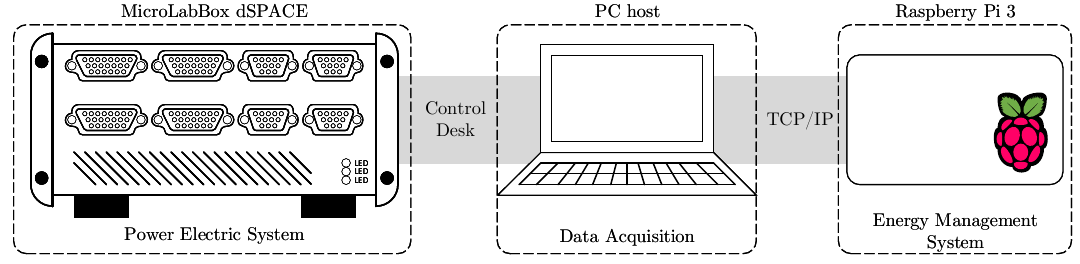
Figure 6. Platform schematic of system emulation with MicroLabBox dSPACE, a Raspberry Pi 3, and a PC